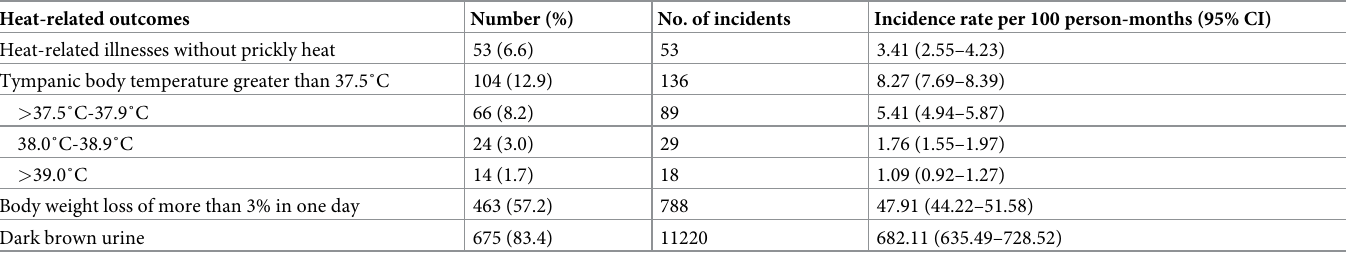
Table 2. Heat-related outcomes among new conscripts during basic military training (n = 809). Heat-related outcomes